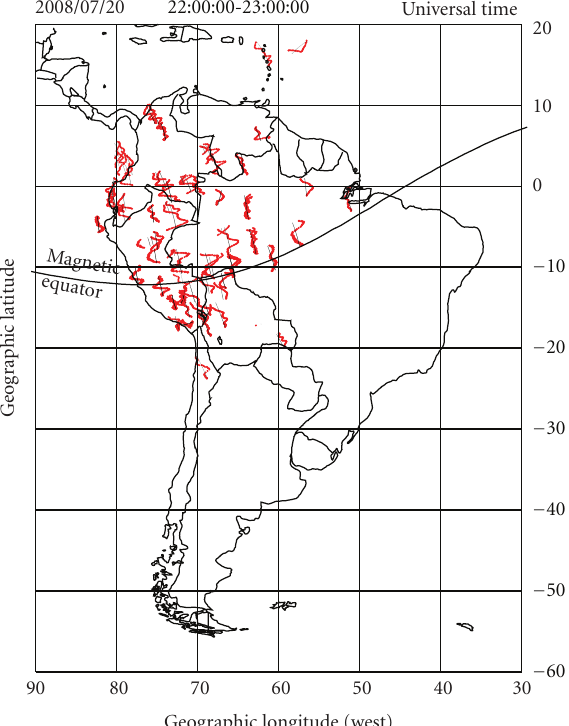
Figure 11: TEC perturbations recorded by several GPS sites that operated in South America on July 20, 2008. The red traces correspond to the TECP values after subtracting the daily